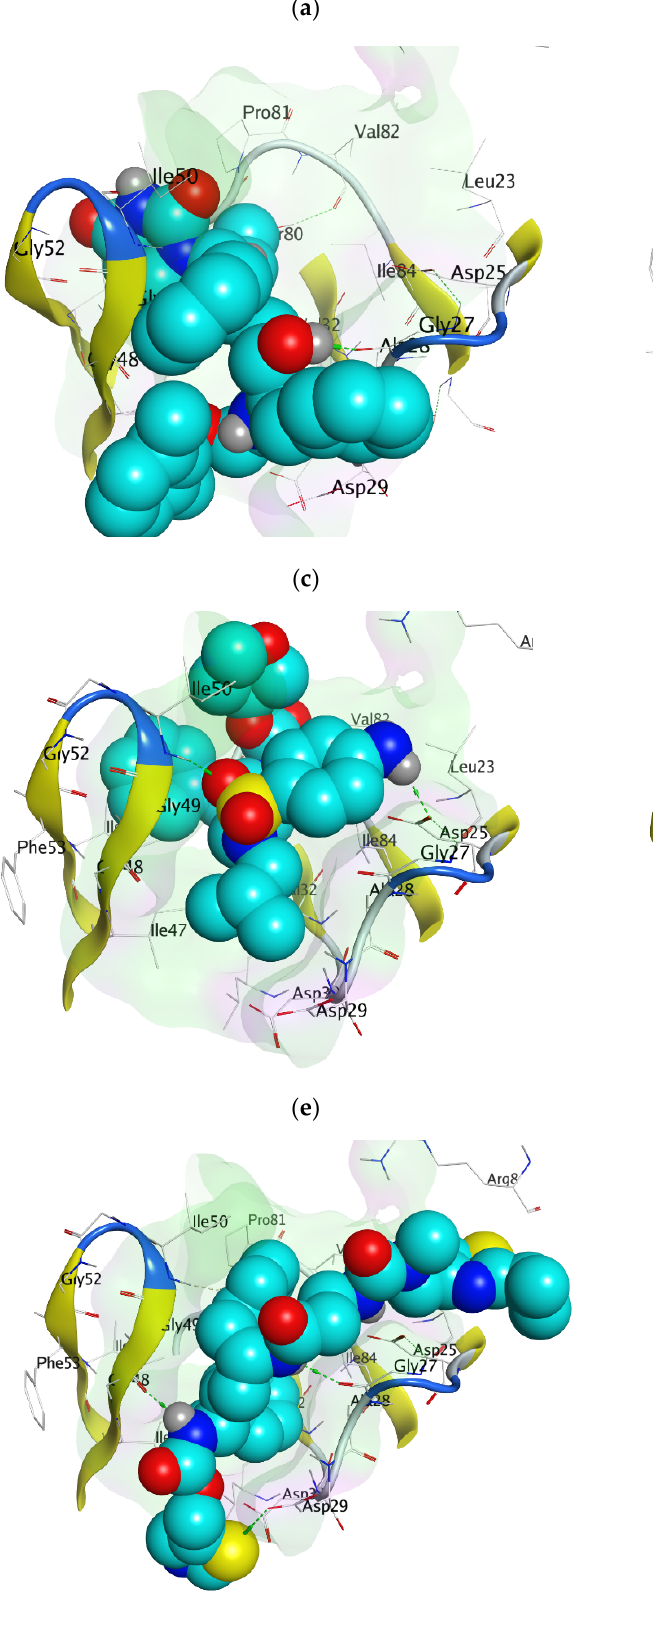
Figure 5. The docking poses of ( a ) HPS/002, ( b ) HPS/004, ( c ) HPS/006, ( d ) HPS/007, ( e ) HPS/008 and ( f ) HPS/009 in the binding cavity of HIV-1 protease. Molecular docking simulation clearly demonstrated significant chemical interactions of the atoms of the ligands and the amino acid residues of the HIV protease (Table 3). The amino acid residues of the HIV-1 protease that interacted with the atoms of the optimized hit compounds (Table 3) are all part of the amino acid residues in the active binding sites. This further elucidates the validity of the docking protocols. All the hit molecules formed prominent hydrogen bonds with at least two catalytic residues (ASP 25, GLY 27 and ASP 29) on the floor of the active site. The carbonyl and the hydroxy group of HPS/002, through hydrogen bond interactions, combined with the O GLY 27 and N ASP 29, respectively. Other important chemical interactions include the pi-H bonding of the two 6-membered aromatic rings with the CG1 of ILE 50 and the CA of GLY 27, respectively. HPS/004 has similar interactions to those exhibited by HPS/002. HSP/002 and HPS/004 have more ef- fective binding interactions with the HIV-1 PR than lopinavir. In addition to using the amino acid residues of the catalytic triad, they also interact effectively with other amino acid residues. These interactions help to stabilize them more in the active binding site of the receptor. The two 5-membered thiazole rings in HPS/007 interacted with NH1 ARG 8, CA GY 49 and CB PRO 81 through pi-H bonding. Furthermore, the S-2 and O-7 atoms of the HPS/007 inhibitor form a hydrogen bond with the CG1 of ILE 50 and CA of GLY 49, respectively. The sulfur atom (S-1) in the thiazole ring of HPS/006 formed two strong H- bonds with the OG1 THR 80 and CD1 ILE 54 through H-donor and H-acceptor interac- tions, respectively. Furthermore, the N-10 atom of the HPS/006 compound interacted with the O GLY 27, forming a strong H-bond. Other amino acid residues that played a vital role in the chemical interactions of HPS/006 and the HIV protease are ASP 25, by interacting with C-29, and GLY 49, by interacting with O-4. Likewise, the S-2 in the thiazole ring of HPS/008 interacted with the carboxyl group of the protease active site residues, ASP 29 and ASP 30 through hydrogen bonding. There were prominent hydrogen bond interac- tions between the 6-membered rings of HPS/008 and the CD1 of ILE 47, and amino nitro- gen of ILE 50 through pi-H bonding. Other amino acid residues that played vital roles in the interactions are: GLY 27, GLY 48 and LYS 45. It was observed that HPS/007 has the highest binding affinity (−8.57 kcal/mol). In addition to the chemical interactions with the residues in the catalytic active site, the two thiazole rings contributed significantly to this high binding affinity of HPS/007 with the HIV protease. Again, the 6-membered aromatic rings, which are common in all the hit molecules played a key role in the chemical inter- actions, which resulted in an improved binding affinity of these molecules to the HIV protease. Figure 5 illustrates the CPK representation of the binding poses of (a) HPS/002